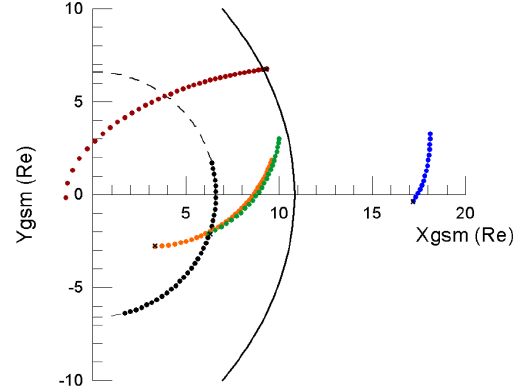
Figure 4. Spacecraft positions in GSM coordinates from 12:00 to 18:00UT on 1 August 2018. The TH-C probe (blue) was in front of the subsolar bow shock. The TH-E (orange), TH-D (green), TH- B (brown), and GOES 12 (black) were located inside the dayside magnetosphere. The magnetopause position (black curve) was cal- culated using OMNI data for the upstream conditions at ∼ 16:00UT following the model by Lin et al.